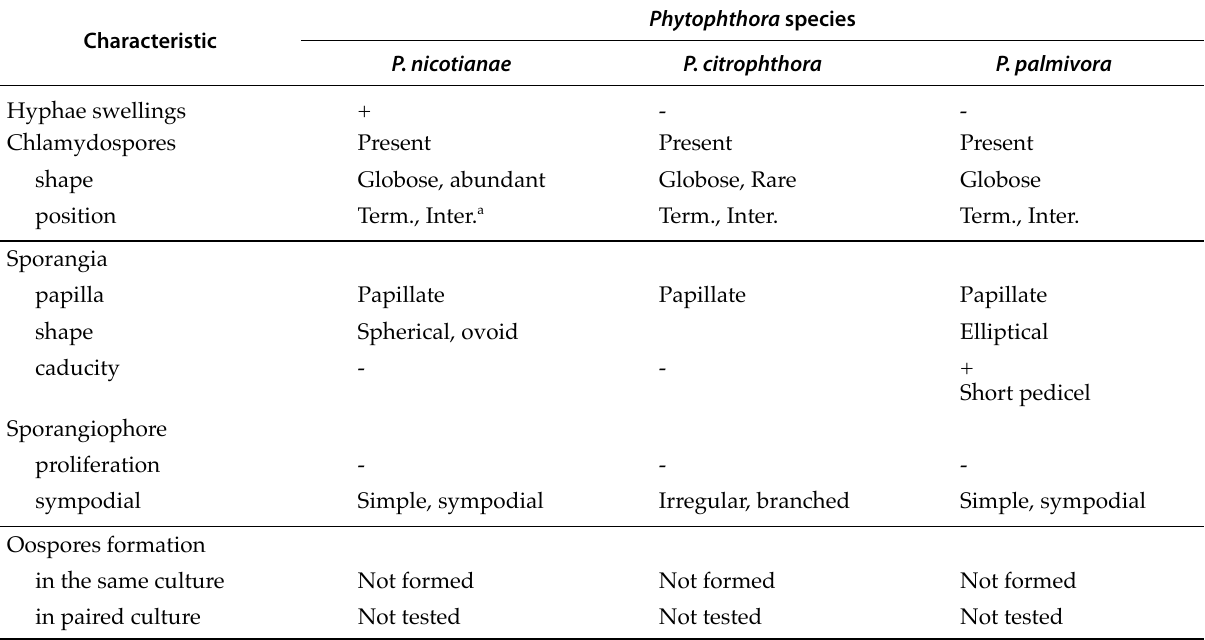
Table 3. Variation in morphological characteristics of isolated Phytophthora